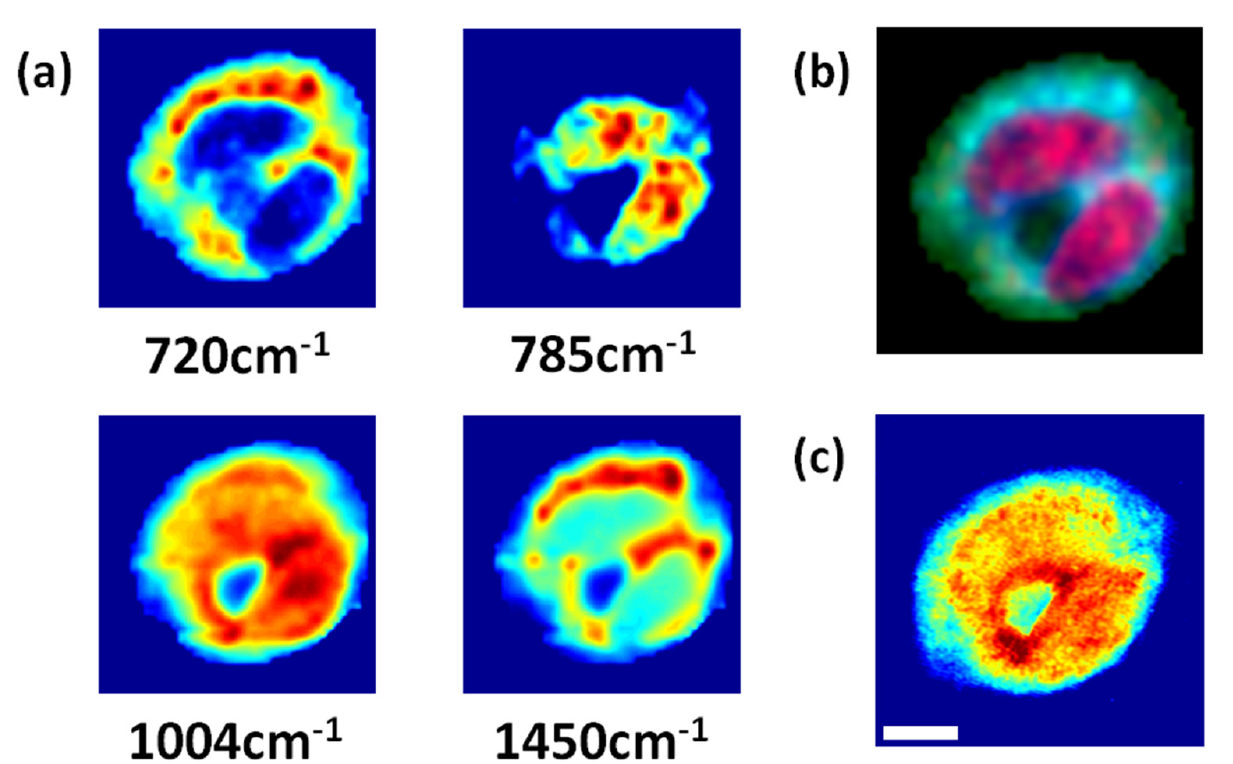
Figure 3. ( a ) Four Raman images reconstructed from live HT ‐ 29 cell (40 × 40 pixels). ( b ) Pseudo ‐ color image reconstructed from 785 cm − 1 (red), 720 cm − 1 (green), and 1450 cm − 1 (blue) Raman bands. ( c ) Quantitative phase microscopy image of the same cell. (Scale bar: 3 µ m) Optical phase delay measured from QPM is similar to the reconstructed image from the 1004 cm − 1 Raman peak.